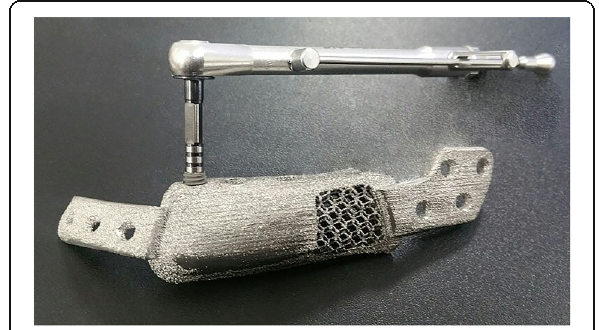
Fig. 4 Titanium implant was inserted to the resected area of left